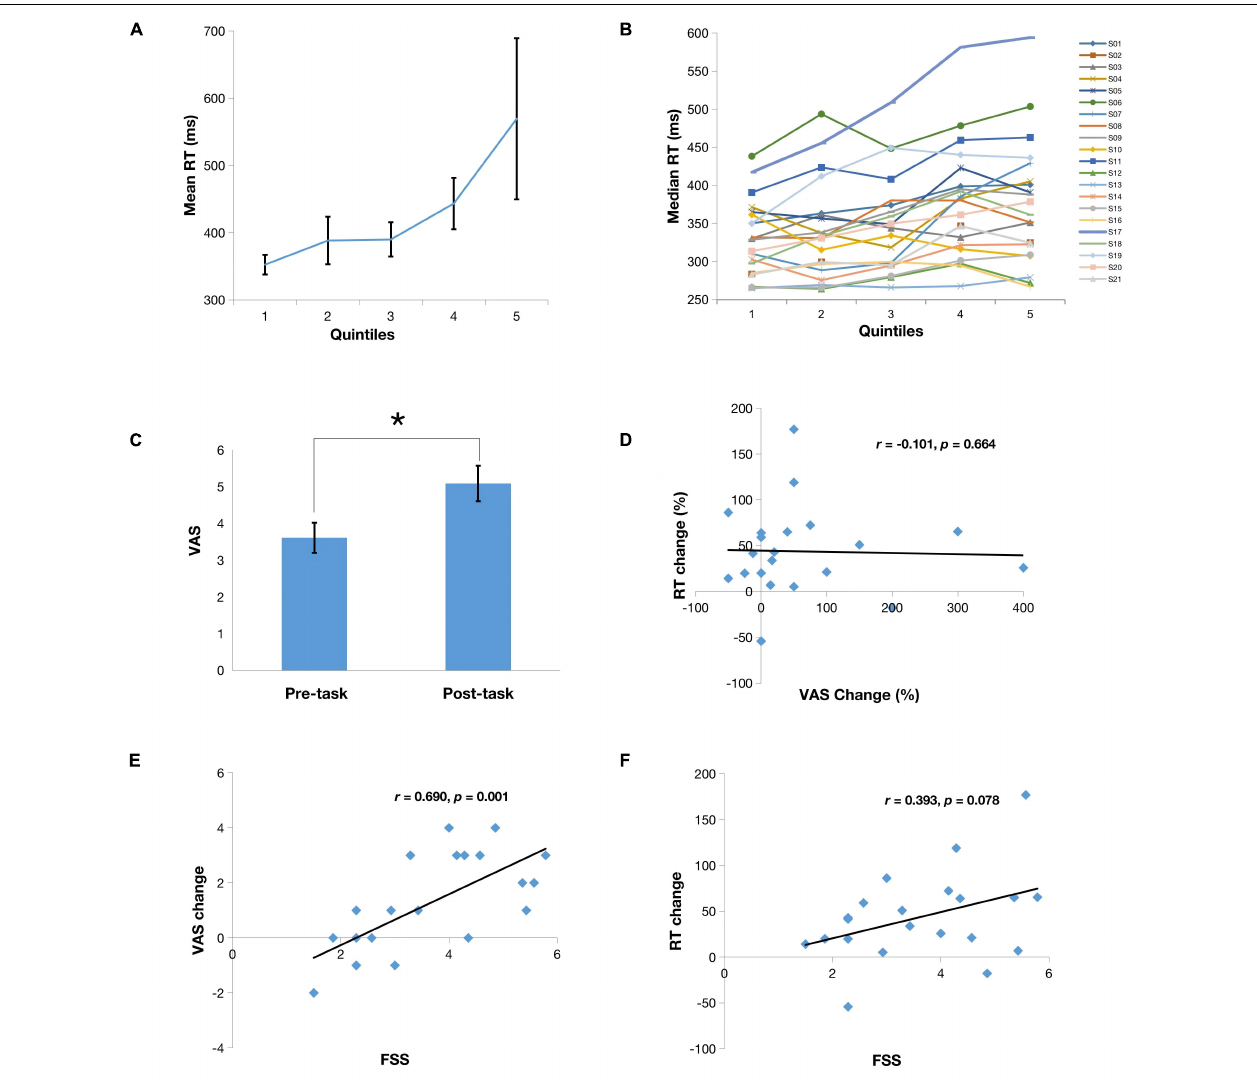
FIGURE 2 | (A) Means of reaction time (RT) from the first to the last quintile. Note there is significant differences between mean RT in the last quintile and the first three quintiles ( p < 0.05); (B) Median RT series of all subjects from the first to the last quintile; (C) Mean scores on a 9-point Visual Analog Scale (VAS) reported by subjects before and after the PVT. Note there is a significant mental fatigue increase after PVT compared to prior PVT ( ∗ p < 0.05); (D) Correlation of VAS change (%) to RT change (%); (E) Correlation of VAS change to Fatigue Severity Scale (FSS); (F) Correlation of RT change to FSS.